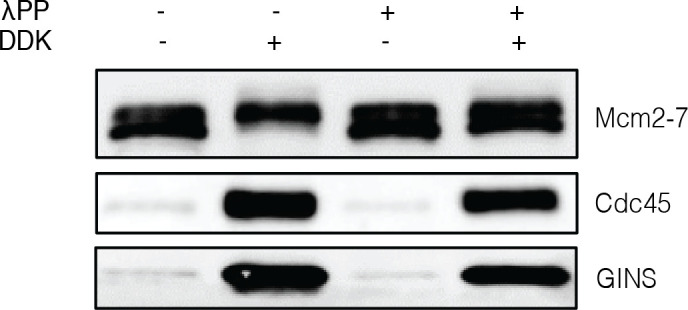
Phosphatase-treated Mcm2-7 remains functional after treatment with phosphatase.Ensemble Cdc45-Mcm2-7-GINS-formation assays were performed as described in Materials and methods. Immunoblots for Mcm2-7, Cdc45, and GINS after HSW2 are shown. As indicated, Mcm2-7 was treated with lambda phosphatase and/or Dbf4-dependent kinase as described in Materials and methods.